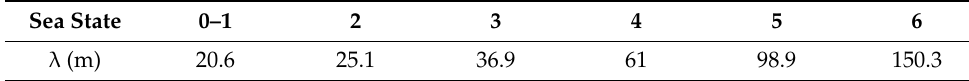
Table 3. Sea state–wave length relations for the Aegean Sea.